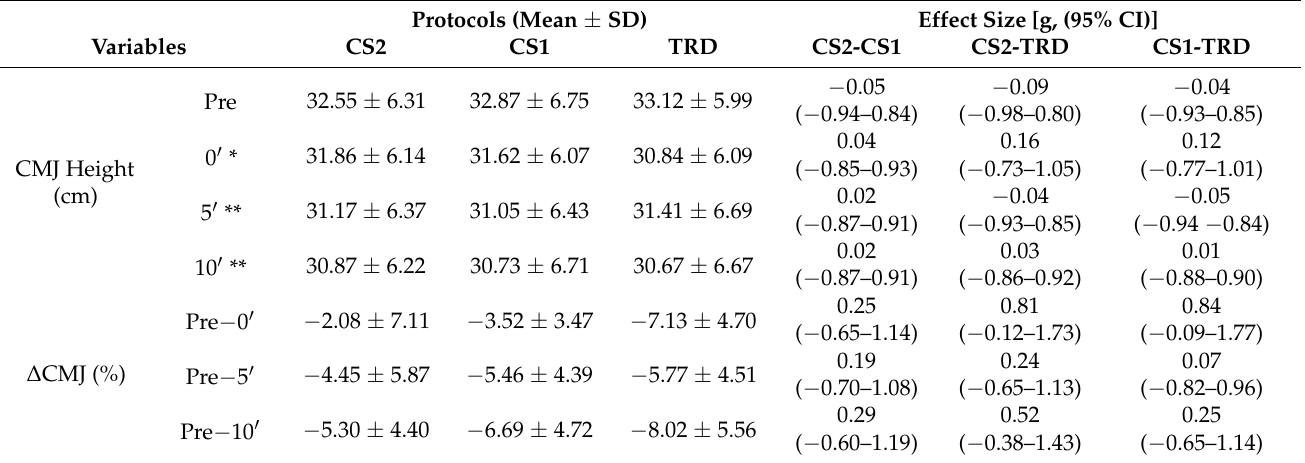
Table 2. Data (mean ± SD) comparison between protocols for all jump performance variables and their respective effect sizes.